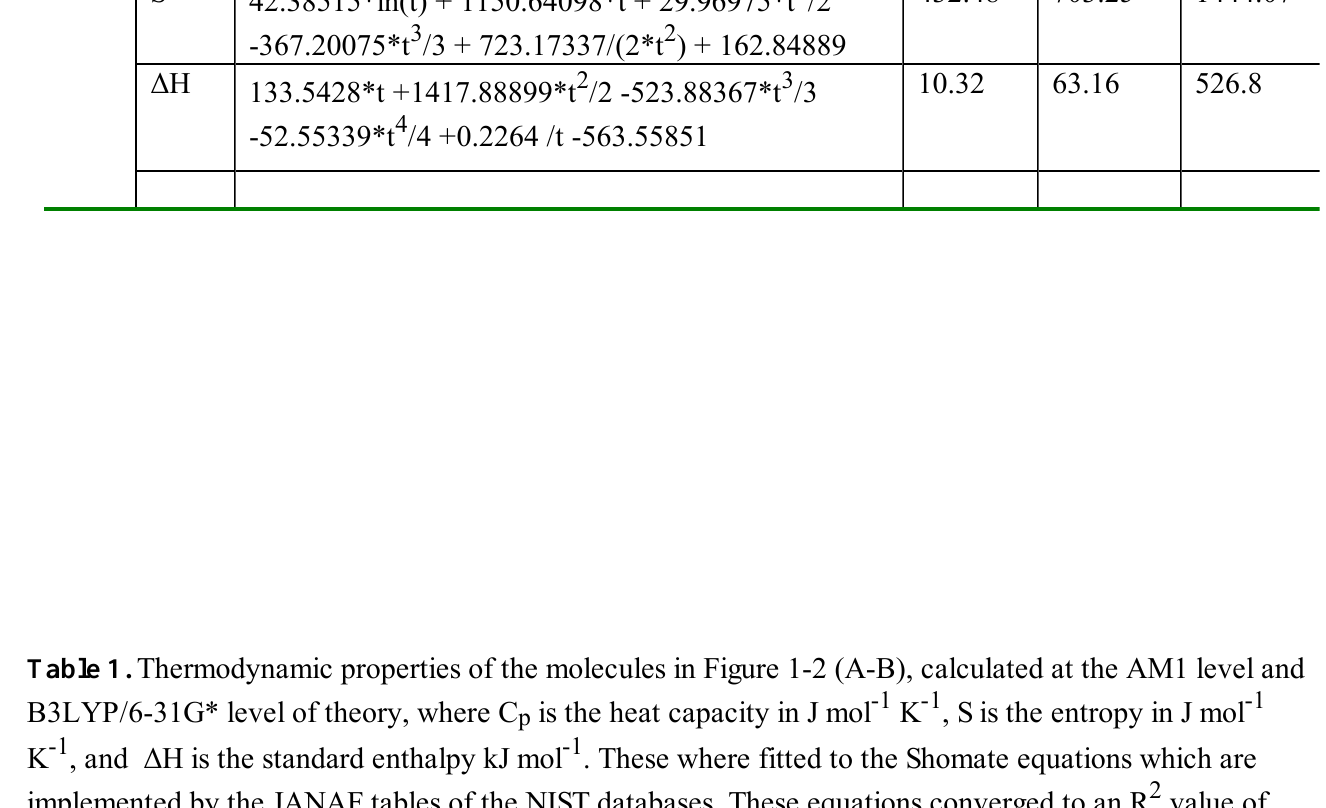
Table 1. Thermodynamic properties of the molecules in Figure 1-2 (A-B), calculated at the AM1 level and B3LYP/6-31G* level of theory, where C p is the heat capacity in J mol -1 K -1 , S is the entropy in J mol -1 K -1 , and Δ H is the standard enthalpy kJ mol -1 . These where fitted to the Shomate equations which are implemented by the JANAF tables of the NIST databases. These equations converged to an R 2 value of 0.999 on average.